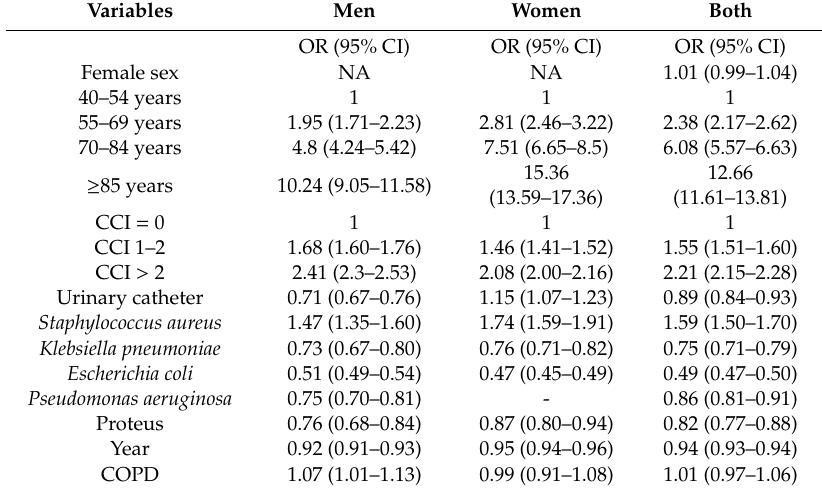
Table 4. Variables associated with in-hospital mortality in hospital admissions of patients with a principal diagnosis of urinary tract infection according to sex in Spain